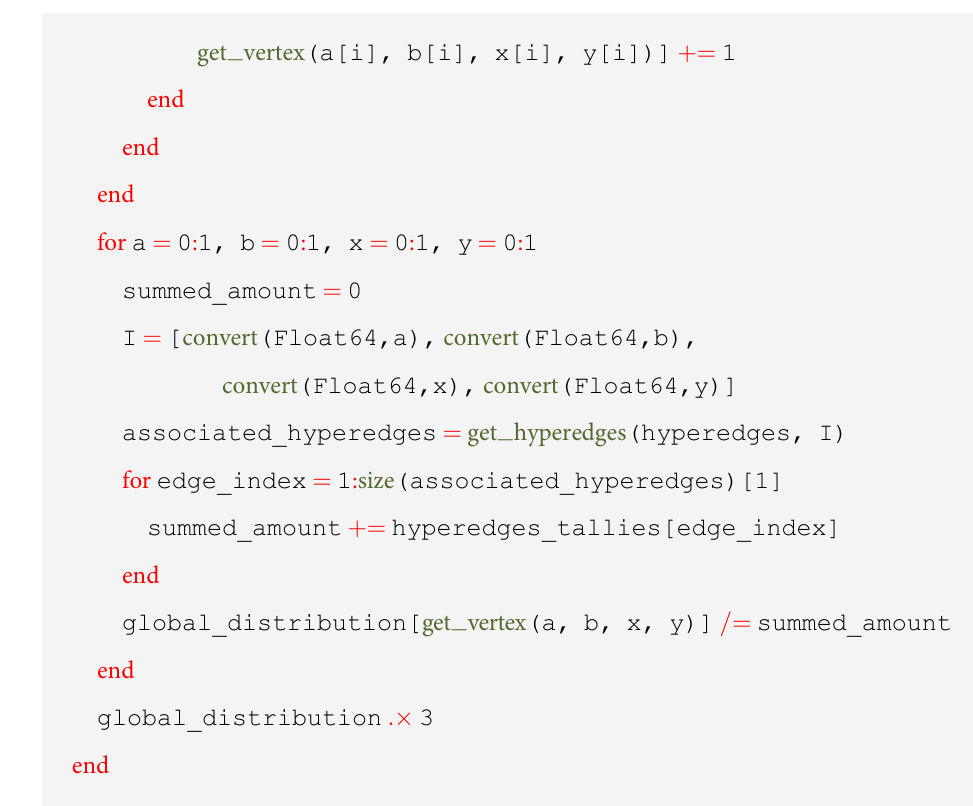
Figaro. To achieve a joint-probability distribution on a measurement context of random variables, Figaro’s syntactic elements reveal fundamental differences in its approach. A class is the advised object for the purpose of declaring a model. For each random variable in the model, a probability bias is applied to Figaro’s Flip method, generating a Bernoulli distribu- tion on which the If method can then associate the results to desired values, or perpetuation of other